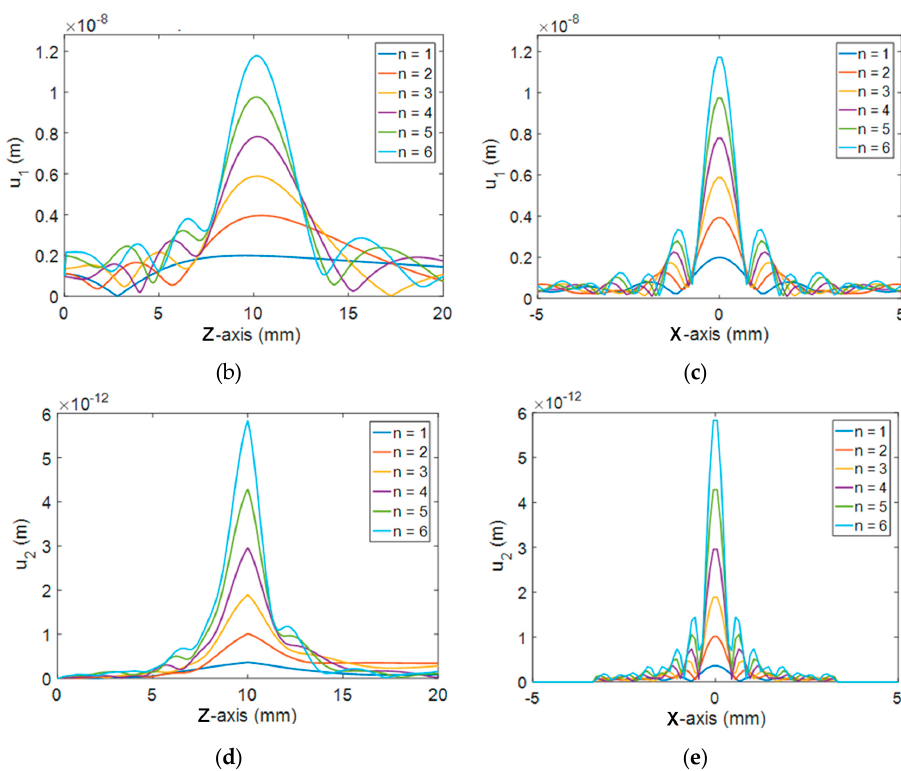
Figure 4. Simulated displacement distribution as a function of the number of Fresnel zones ( F = 1 cm, f = 5 MHz, even FZP): ( a ) 2D beam profile of the fundamental (left column) and second harmonic (right column) waves, ( b ) on-axis distribution of the fundamental wave, ( c ) lateral distribution of the fundamental wave at the focal plane, ( d ) on-axis distribution of the second harmonic and ( e ) lateral distribution of the second harmonic at the focal plane.